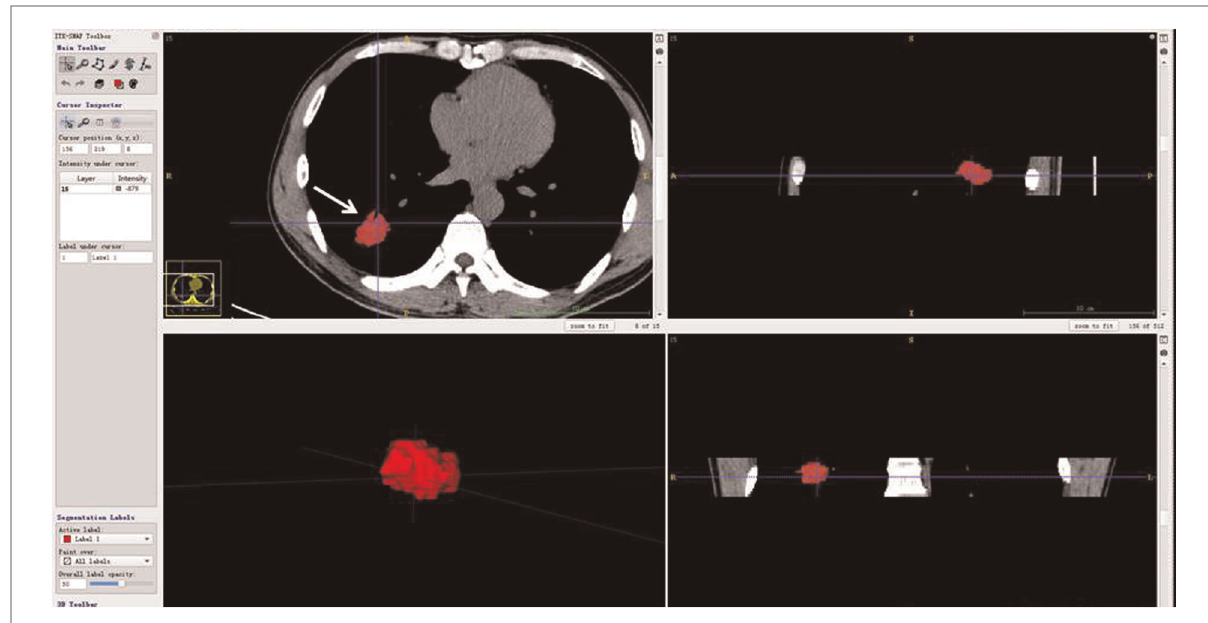
FIGURE 2 CT scan of the patient (woman, 77 years old) showing a solid nodule in the post-basal segment of the right lower lobe, which proved to be lung in fi ltrating adenocarcinoma. The 3-dimensional imaging (all slices) of segmentation was imported into AK software (Arti fi cial Intelligence Kit, Version 3.3.0, GE Healthcare) (13) for feature extraction. The imaging presented unenhanced imaging: the left upper fi gure was cut into images (arrow), the left lower fi gure was cut into whole nodules, and the upper and lower fi gures on the right are vertical plane and coronal plane images of the cut